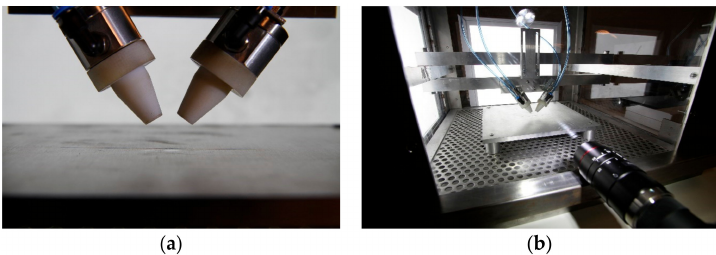
Figure 2. ( a ) Deposition nozzle configuration; ( b ) custom feeding system demonstrator at SUPSI.